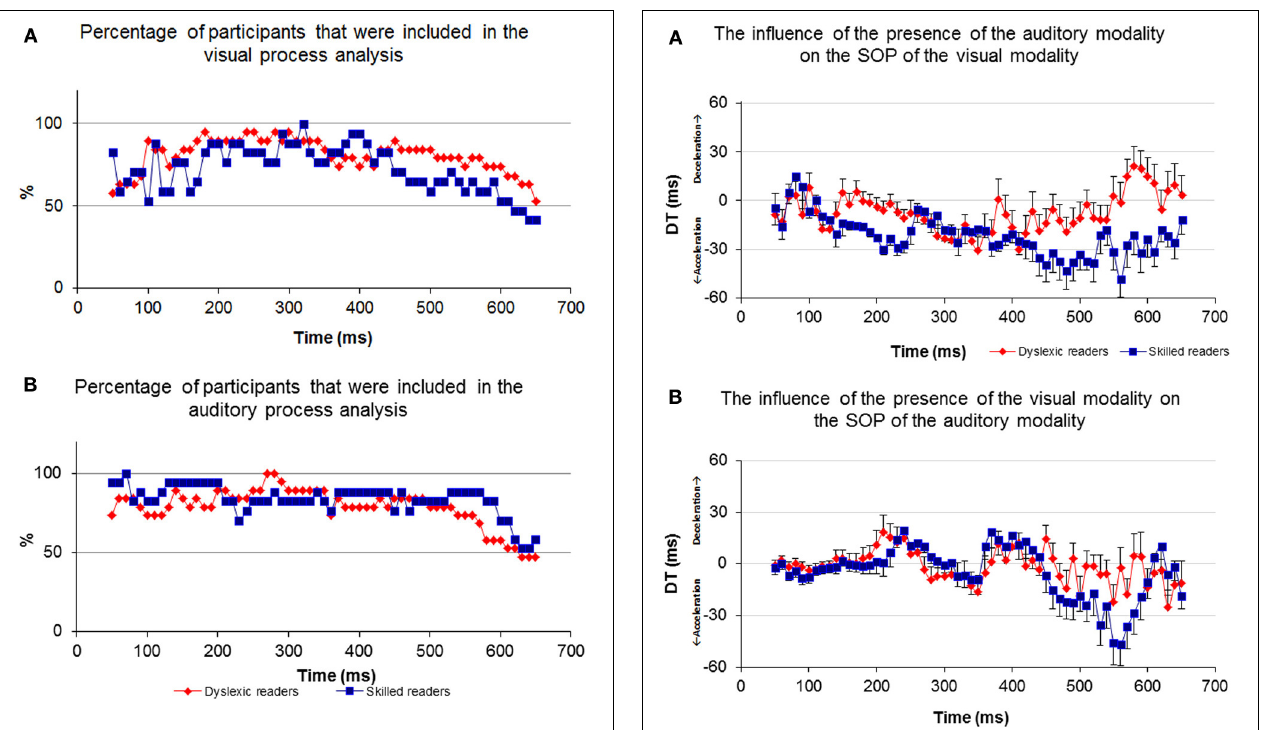
FIGURE 6 | Average DT of the two groups for each time window. Axis X represents time and axis Y represents DT. (A) The DT results of the visual-only and the crossmodal ERPs. (B) The DT results of the auditory-only and the crossmodal ERPs.